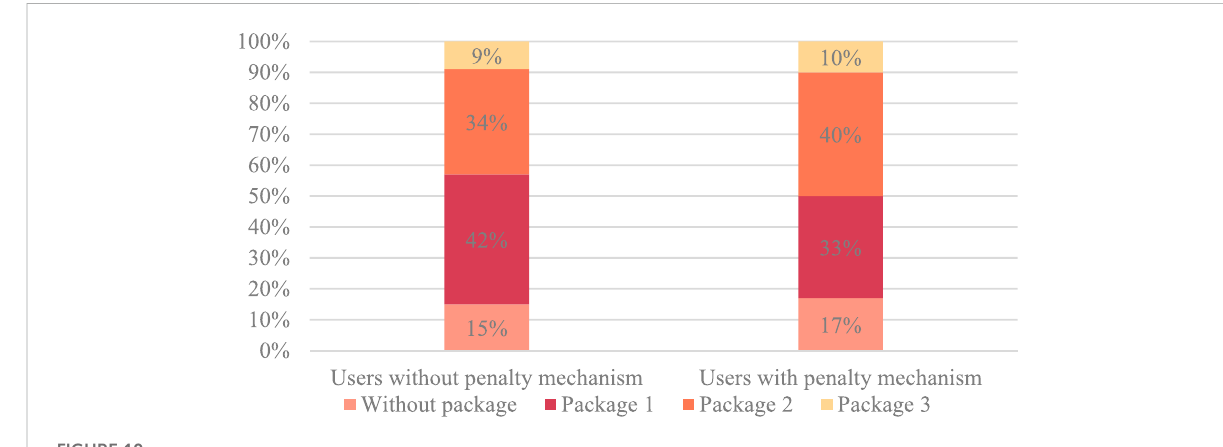
FIGURE 10 Probability of users choosing different packages with and without the penalty mechanism.